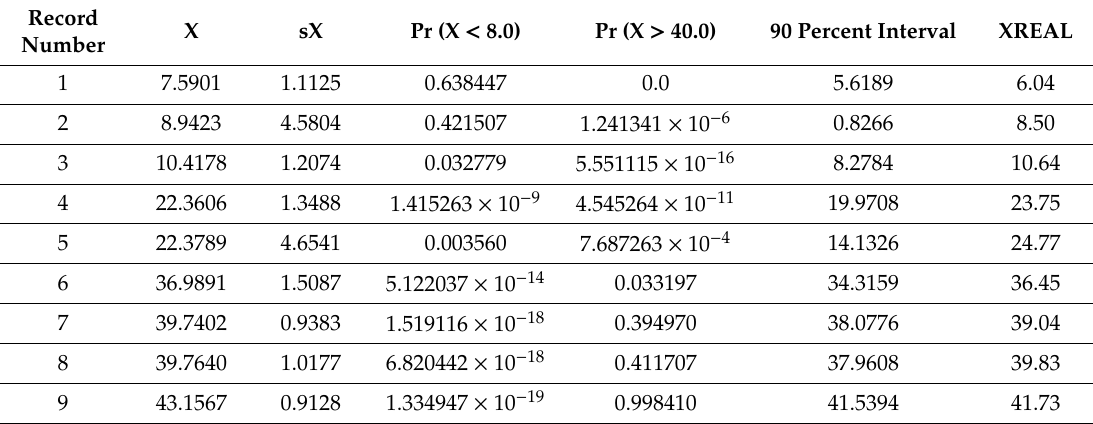
Table 2. Sample predictions of X along with their corresponding threshold-crossing